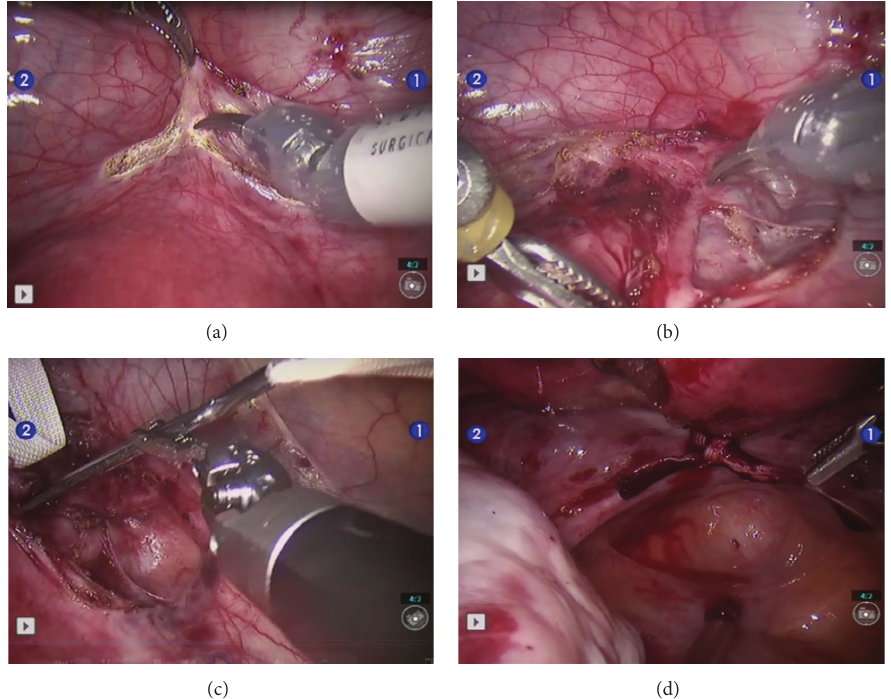
Figure 1: Robotic-assisted abdominal cerclage. (a) Preparation of the vesicouterine peritoneal flap, (b) dissection of the uterine artery, (c) passing of the suture, and (d) tying of the mersilene